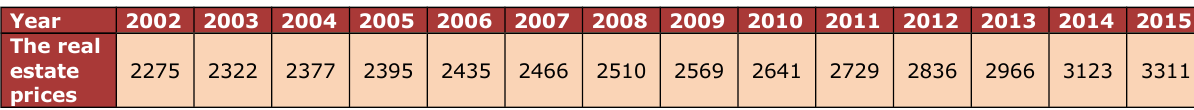
Table 2. The prediction results of the real estate